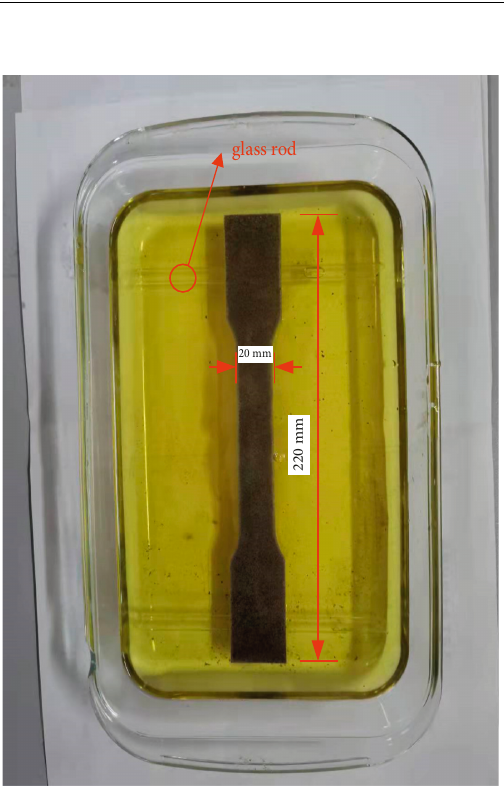
Figure 3: Corrosion exposure of test